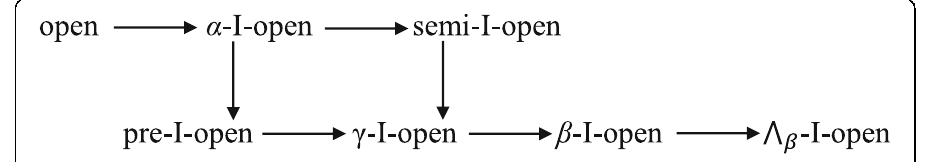
Fig. 1 The relationships between ideal near open